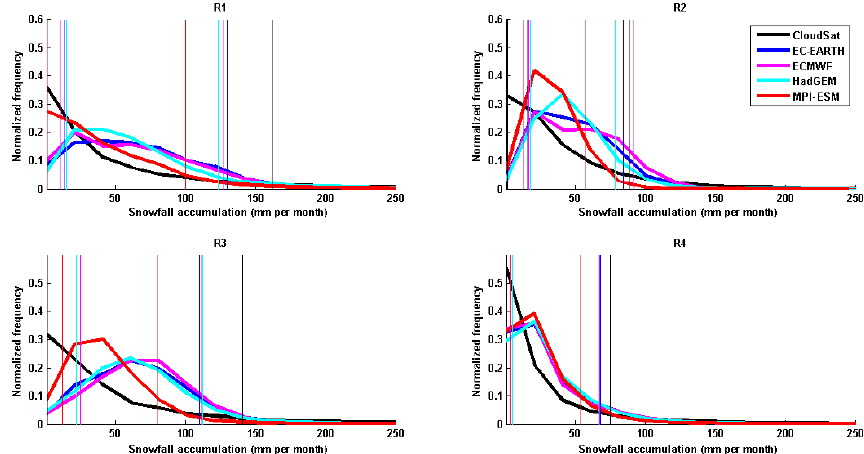
Figure 7. Statistical distribution of snowfall accumulation (mmmonth − 1 ) over the three regions (R1–R3) shown in Fig. 5 and R4: over the entire Arctic (70–82 ◦ N) from Hi-res models and CloudSat observations. The vertical lines denote the p10 and p90